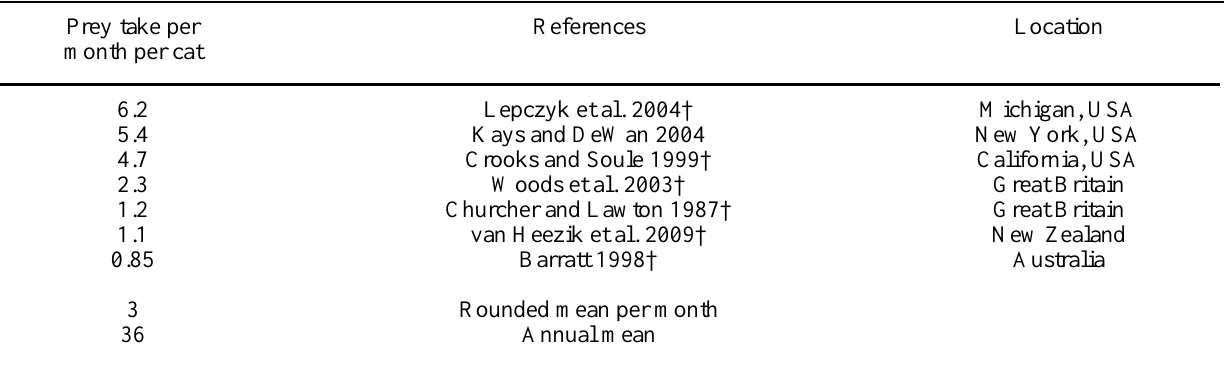
Table 3 . Estimates from the literature used to inform the Wildlife Take node Prey take per month per cat